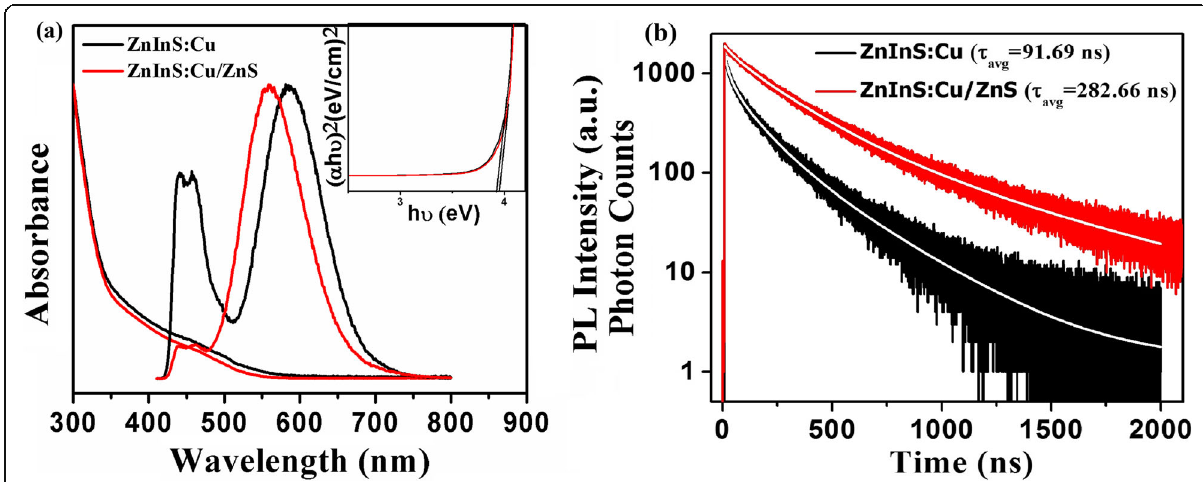
Fig. 2 a UV-visible absorption and PL emission spectra and b PL decay curves of the ZnInS:Cu (core) and ZnInS:Cu/ZnS (core/shell) CNCs. The inset in a shows variation of ( α E) 1/2 as a function of the photon energy with shell